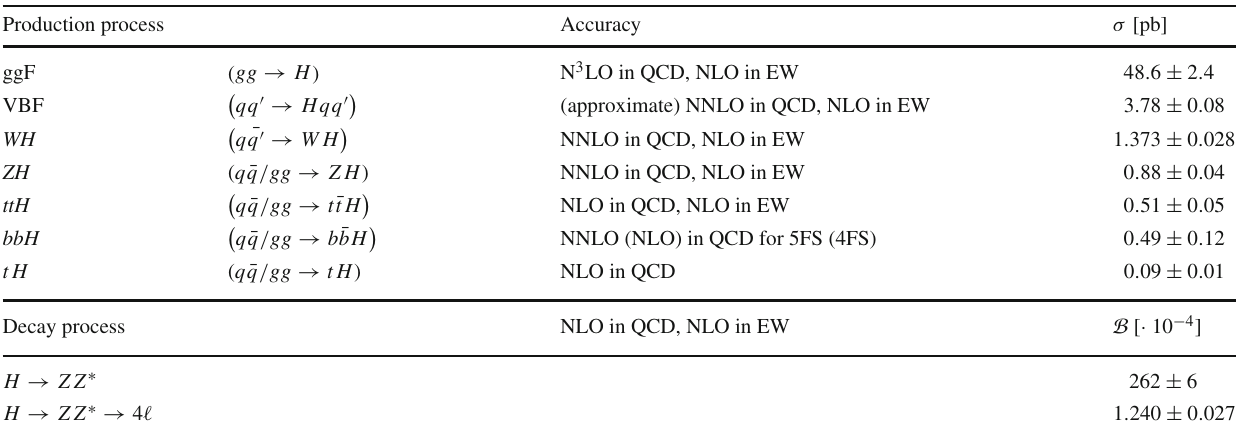
ties calculated by adding in quadrature the uncertainties due to missing higher-order corrections and PDF + α s . The decay branching ratios ( B ) with the associated uncertainty for H → Z Z ∗ and H → Z Z ∗ → 4 (cid:3) , with (cid:3) = e ,μ , are also given